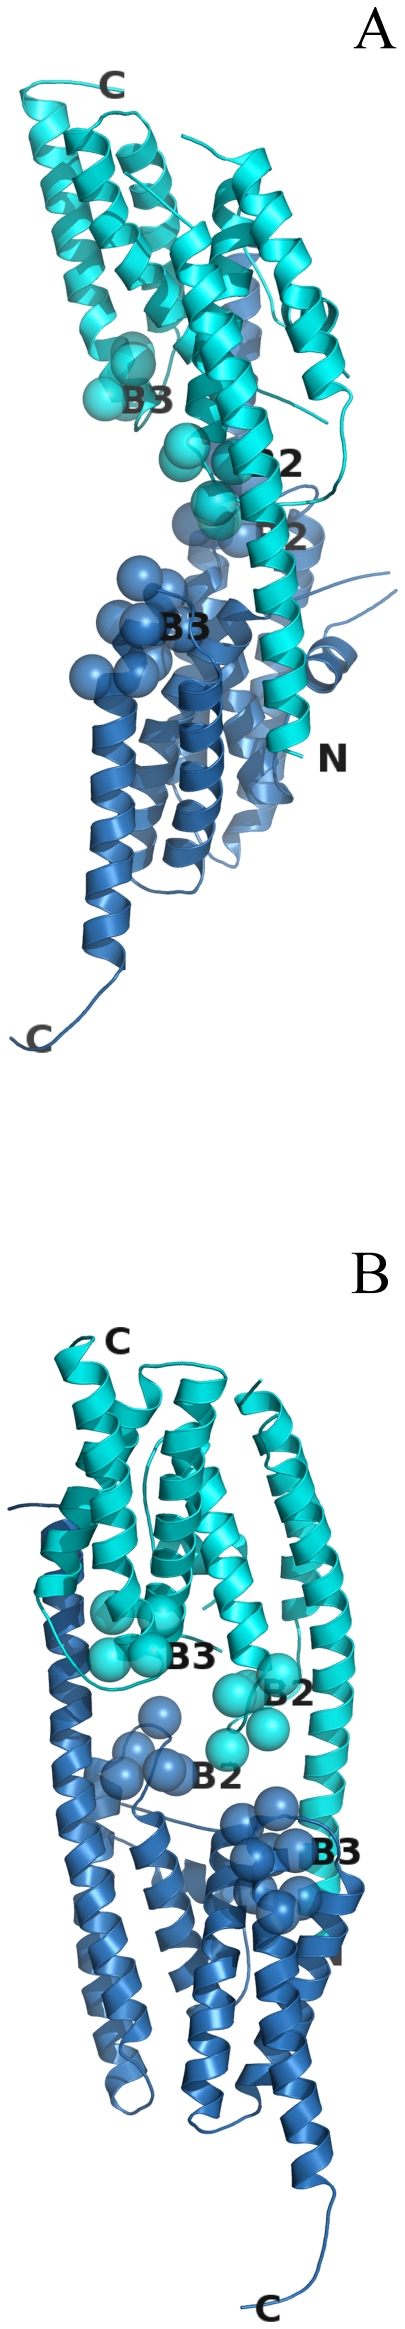
Cartoon showing close proximity of B2 and B3 motifs on human translin-TRAX heterodimer.Different views (A,B) of cartoon showing B2 and B3 motifs (spheres) of translin (cyan) and TRAX (blue) in translin-TRAX heterodimer. The figure was prepared using atomic coordinates of translin-TRAX complex structure (PDB code, 3PJA) and PyMol suite [35].